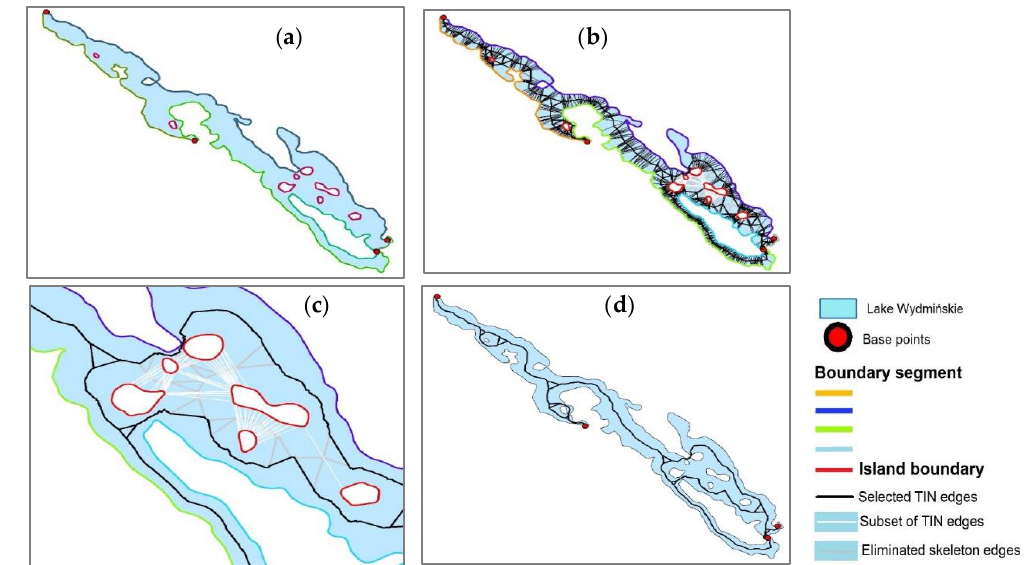
Figure 26. Modification of the base skeleton to obtain a skeleton located along the lake’s external boundaries when the boundaries of all islands are assigned an identical ID: ( a ) the segments of island boundaries are assigned new identifiers, and the island boundary lines are marked with the same color; ( b ) the subset of TIN edges for modifying the skeleton is marked in white; ( c ) elimination of skeleton edges that touch the subset of TIN edges; ( d ) the resulting skeleton.